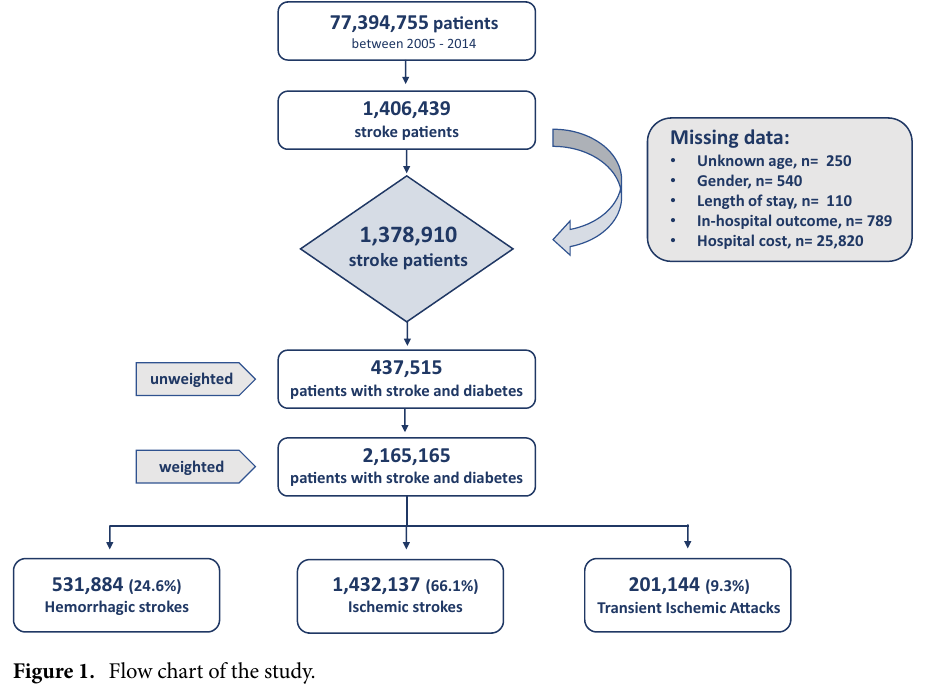
Figure 1. Flow chart of the